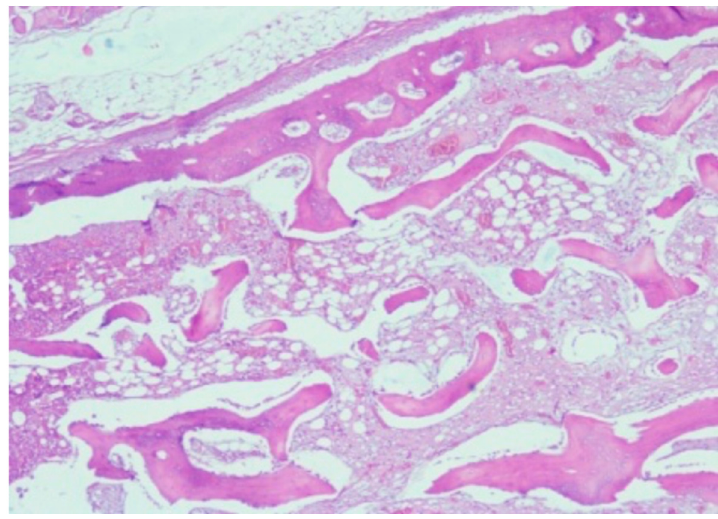
Figure 6. Osseous integration of titanium plate implanted into a partially resected mandible.